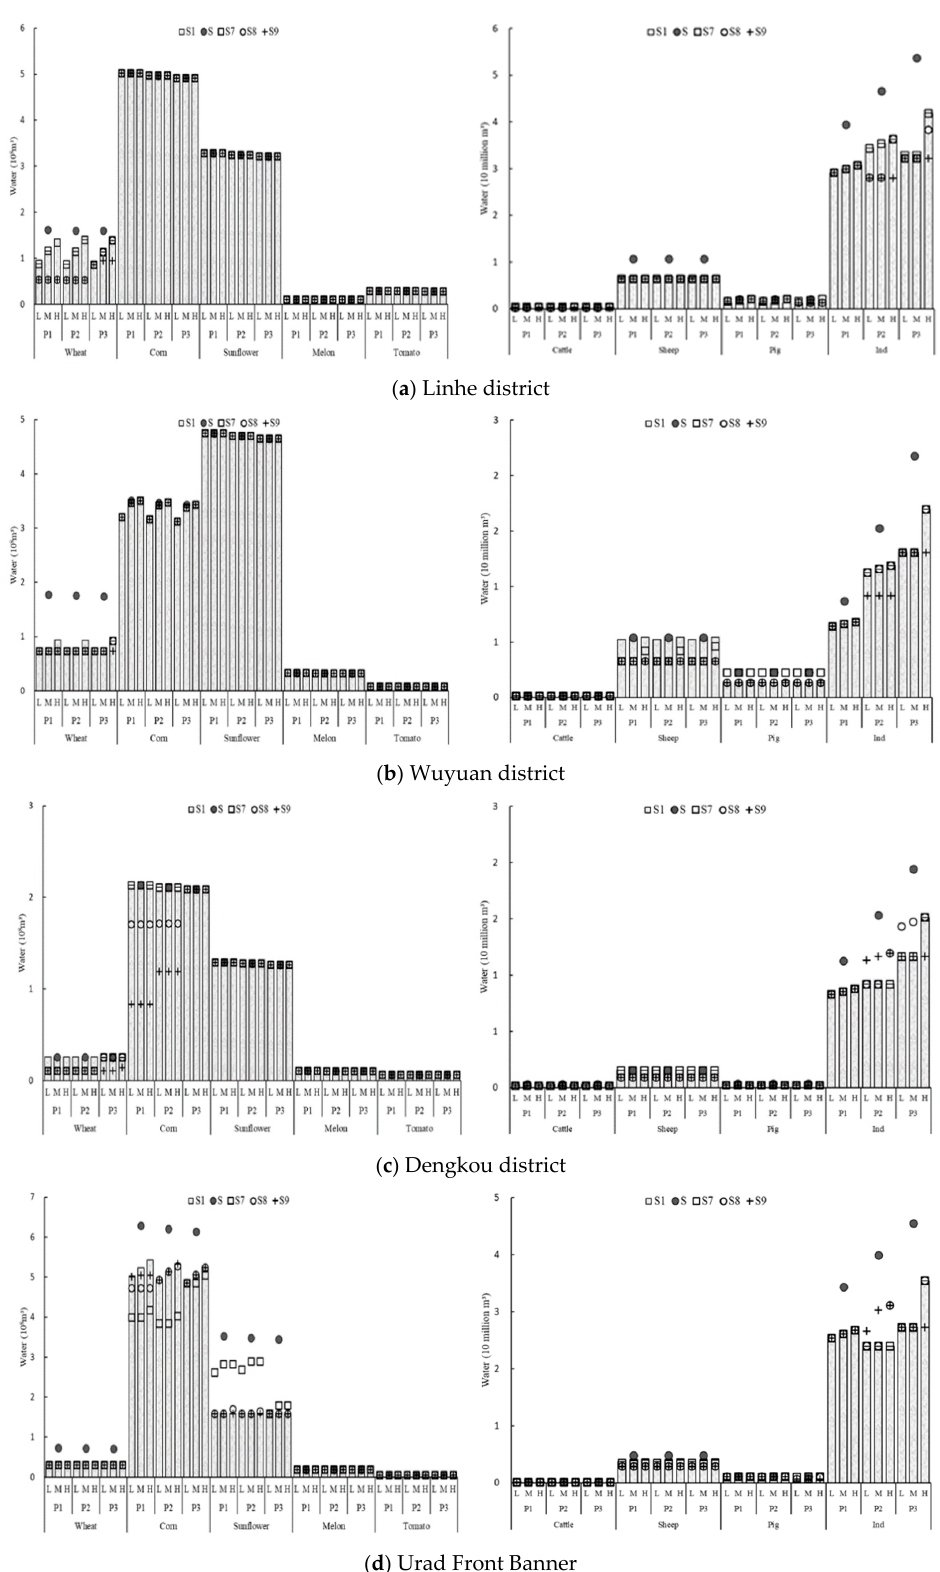
Figure 11. The overall COD pollutant load industry, construction and service in Bayan Nur City under nine scenarios. ( a ) Overall industry, construction and service. ( b ) Each sector.